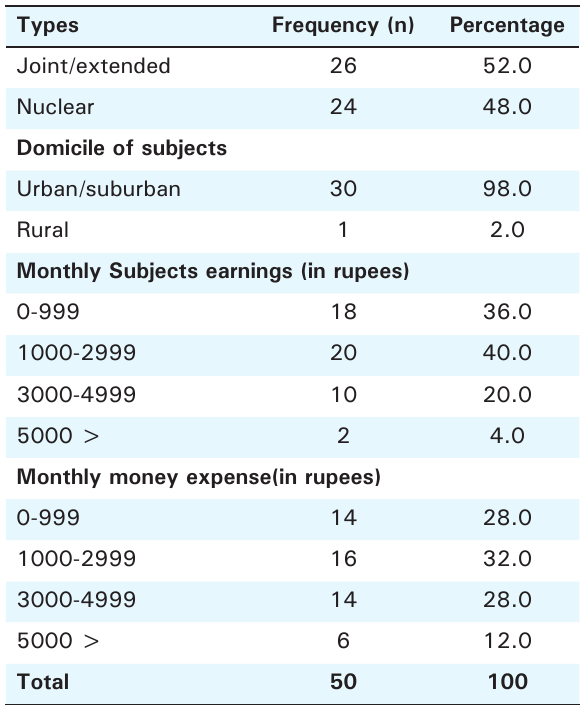
Table 2. Types of household structure